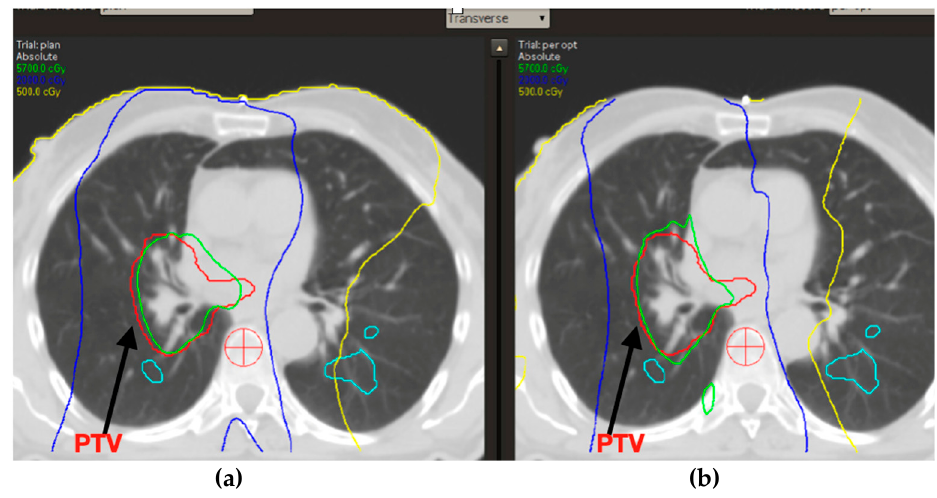
Figure 3. ( a ) Standard RT plan and ( b ) SPECT/CT-optimized RT plan. Mean dose, V5 and V20 for lung-PTV were substantially equivalent for standard RT plans and SPECT-based ones. No differences were observed for isoROI 20%, while a slight but significant improvement in mean lung dose was found in terms of isoROI 40%. Better results for all abovementioned dosimetric parameters were achieved for the isoROI 60% and 80% in the SPECT-optimized plan (Table 3). Table 3. Results of the DVH analysis of the isoROIs of plane 1 and plane 2. IsoROI > 20% Max